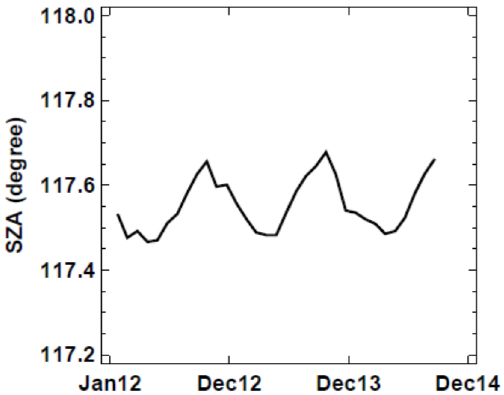
Figure 5. Stray light corrected images for December 3, 2013, 7:43 GMT, using LUTs derived from ( a ) 2013 December, ( b ) 2013 November, and ( c ) 2012 December data.